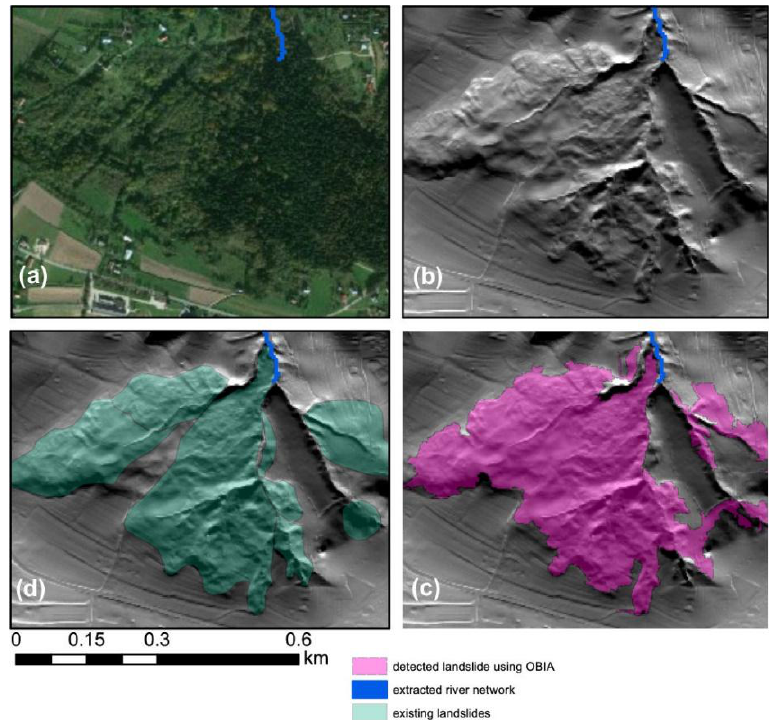
Figure 9. OBIA results in cases of forested areas: ( a ) Ortophoto, ( b ) shaded DEM, ( c ) landslide detected using OBIA, and ( d ) existing landslide in SOPO database.